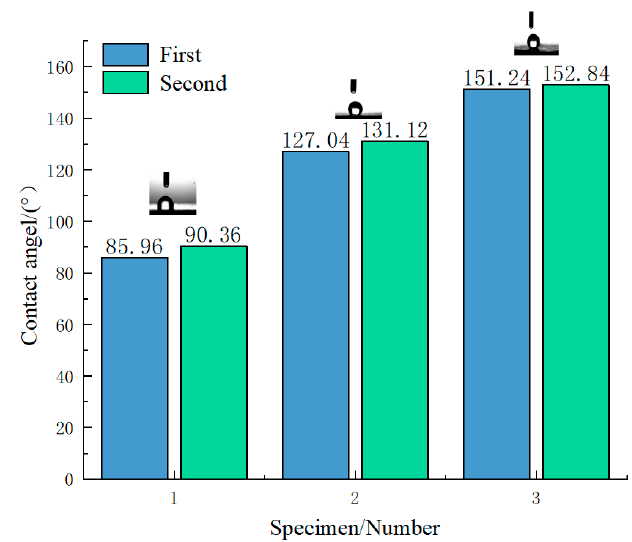
Figure 3. Superhydrophobic contact angle of each